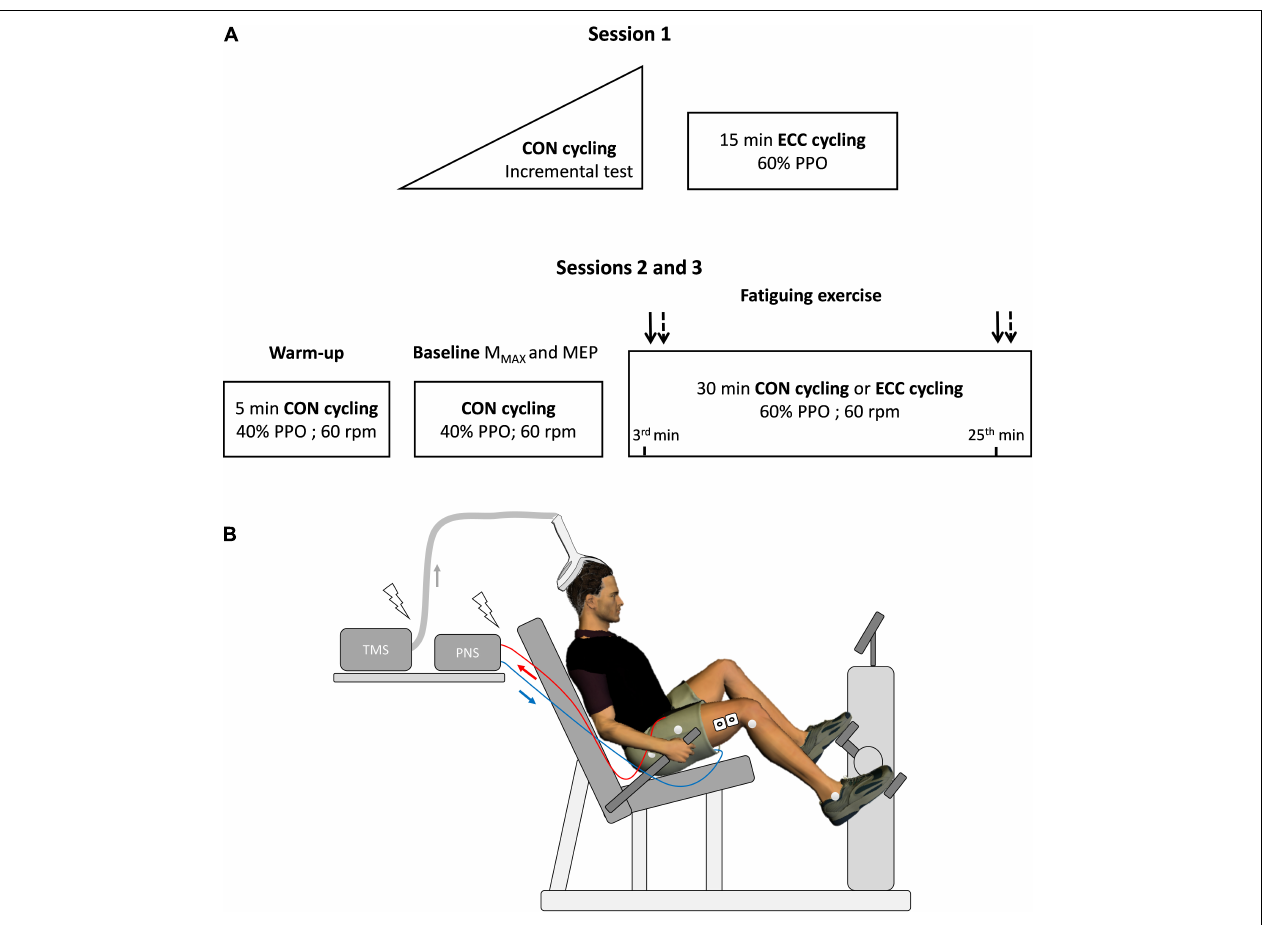
FIGURE 1 | Overview of the experimental protocol. In (A) , a first session served to determine peak power output (PPO, W) during a concentric (CON) incremental cycling test before familiarizing participants with eccentric cycling (ECC). During the experimental sessions (2 and 3), maximal muscle action potential (M MAX ) and motor-evoked potential (MEP) were obtained using electrical stimulation of the femoral nerve and transcranial magnetic stimulation (TMS), respectively. Baseline measurements lasted about 10 min. M MAX (plain arrows) and MEP (dashed arrows), were also measured at the 3rd and 25th min of the strenuous exercises. Heart rate and effort perception were assessed at the same time points. rpm: rotations per minute. The experimental set-up is illustrated in (B) , with electromyographic electrodes on the vastus lateralis muscle (as well as the rectus femoris and vastus medialis, not represented in the figure) and reflective markers positioned directly on the skin on anatomical points chosen to calculate knee flexion angle. PNS: Peripheral nervous